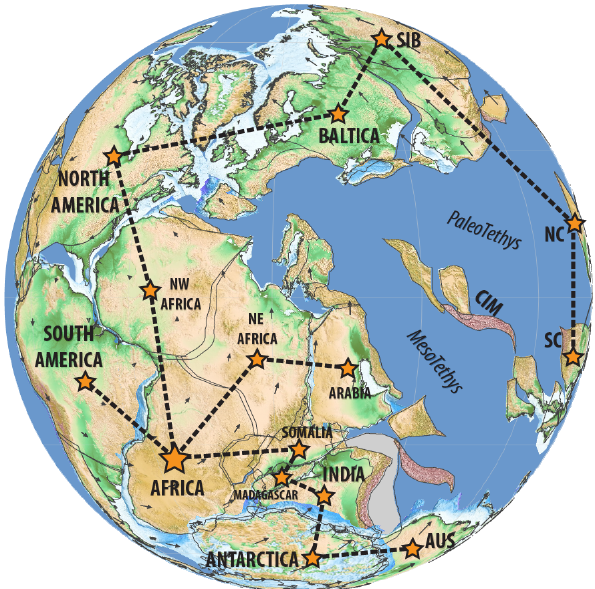
Fig. 1. Plate reconstruction of Pangea at 250Ma in GPlates with plate velocity vectors, reconstructed present-day topography and coastlines for reference. Continental overlaps indicate post-breakup extension of continental crust. Dashed lines indicate our relative plate motion hierarchy in the Paleozoic based on Golonka (2007), with Africa as our reference plate that moves relative to the spin axis using rotations derived in GPlates from the spherical spline option from the Geocentric Axial Dipole (GAD) reference frame in Torsvik and Van der Voo (2002). Abbreviations: NC – North China, SIB – Siberia. Fig. 2. Generalised workflow of converting Paleobiology Database